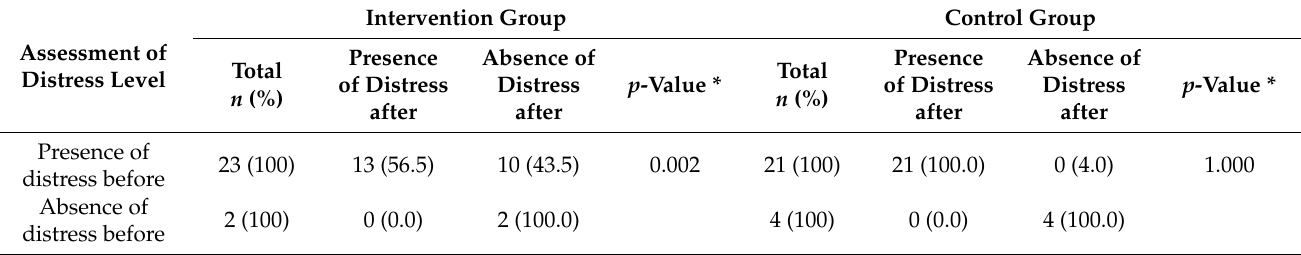
Table 4. Comparison of distress levels before and after interventions between the two groups. Teresina, Piau í , Brazil. 2020.